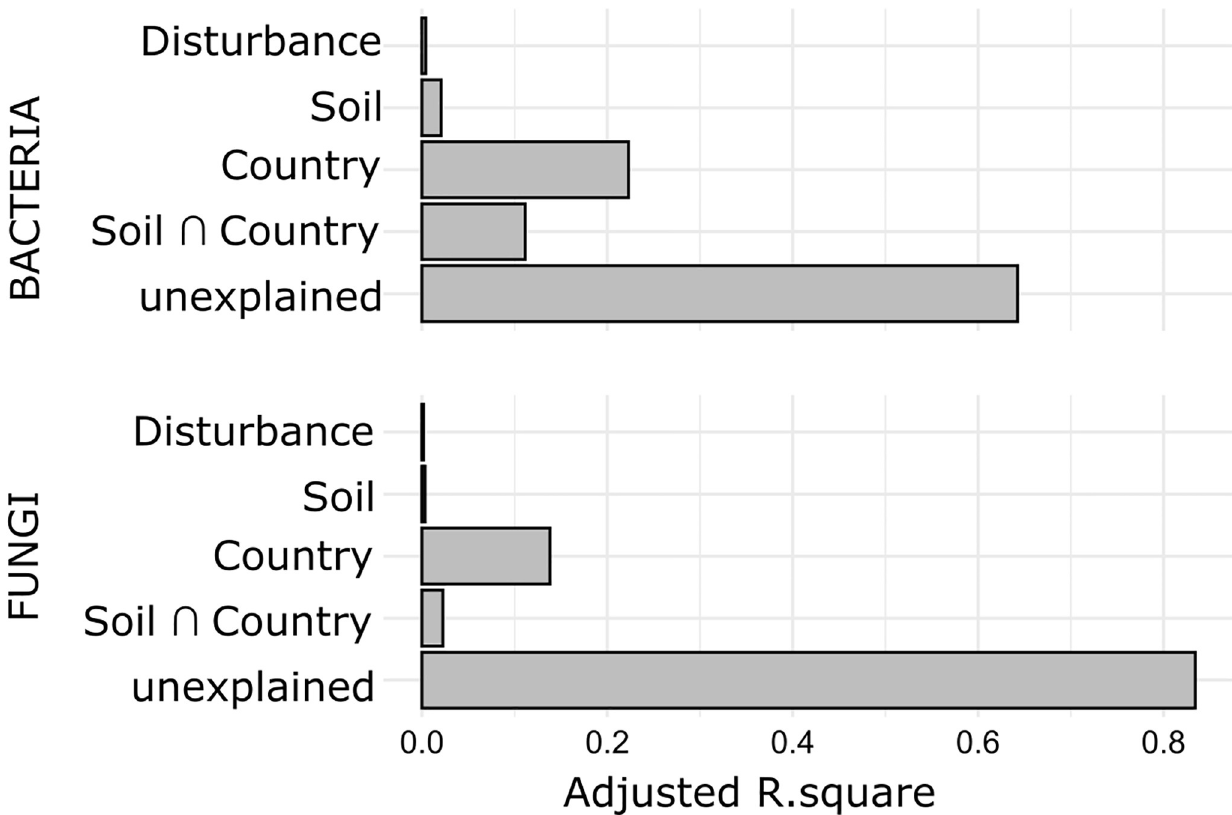
Fig 2. Variance partitioning based on db-RDA of vineyard soil bacterial and fungal communities. Adjusted R-squared values expressing relative amount of explained variation of communities by disturbance, soil covariates, country, as well as the intersection of soil variables and country. Fractions with adjusted R-squared values of zero not